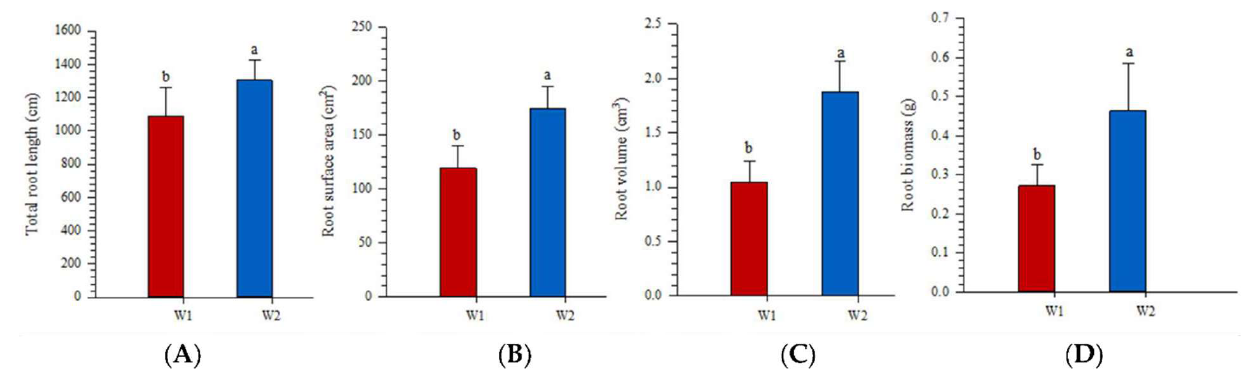
Figure 2. Effects of water addition on total root length ( A ), root surface area ( B ), root volume ( C ) and root biomass ( D ). Bars with the same letters were not significantly different ( p > 0.05) using Tukey’s test. Error bars indicate standard error of means. W1 = 25% FMC, W2 = 75% FMC.